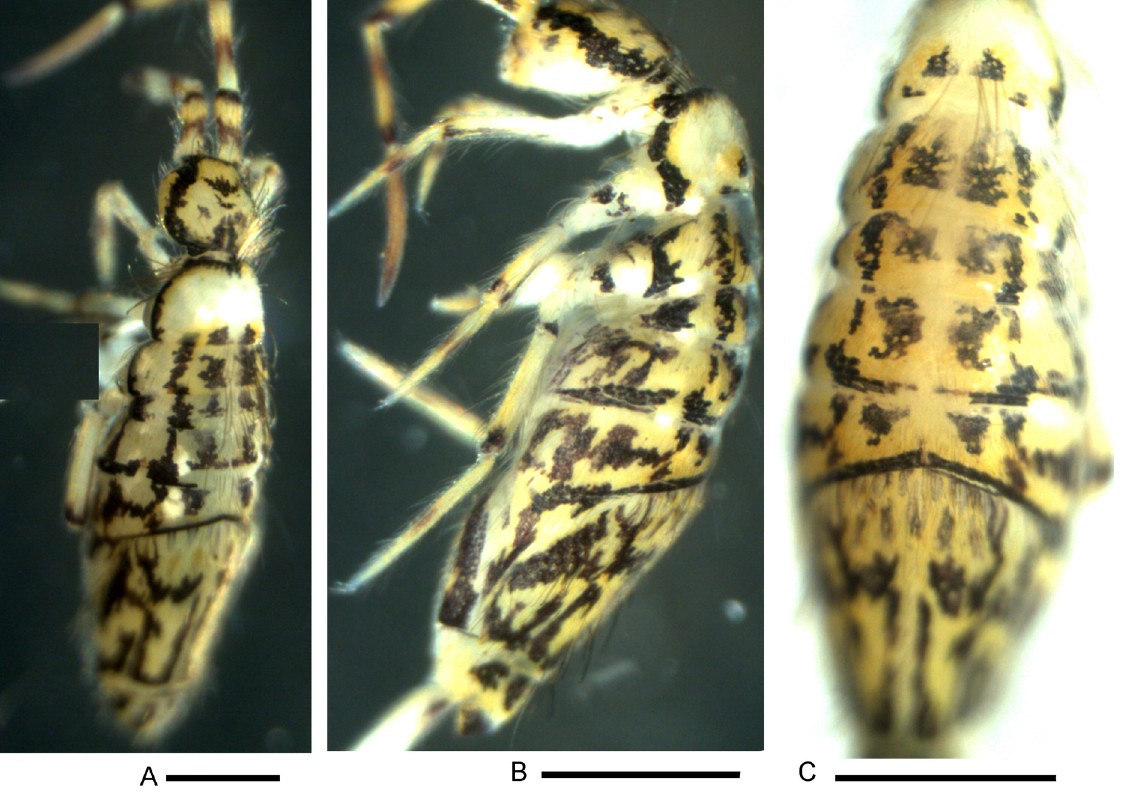
Fig. 6. Entomobrya polychaeta sp. nov. A–C . Habitus. Scales bars: A–C = 500